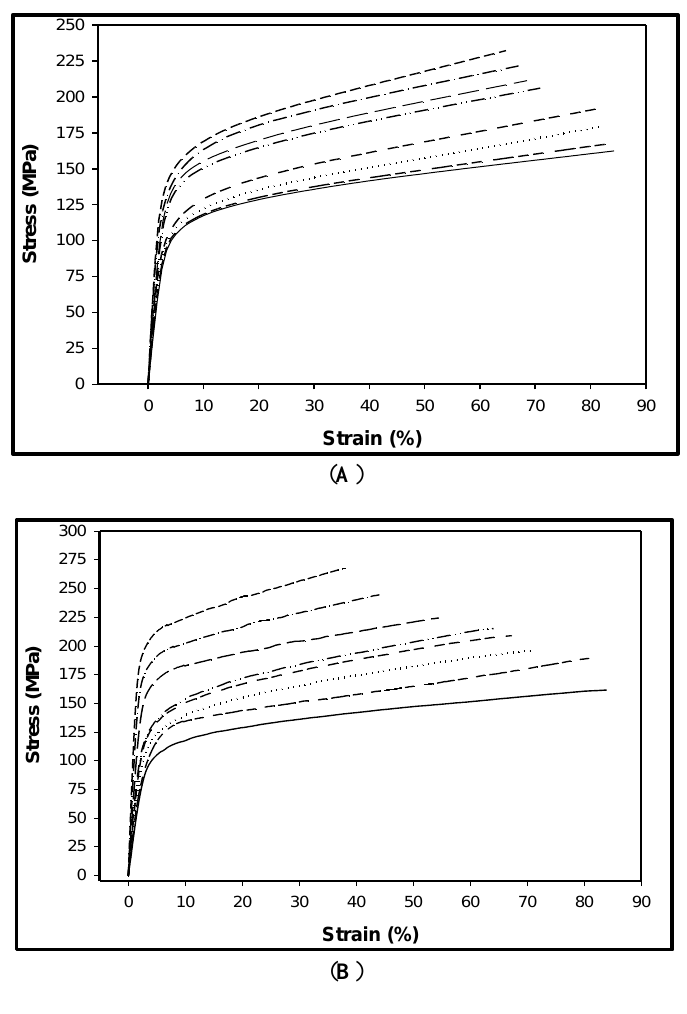
Figure 9. Stress vs strain curves of Ar-CNT-P ( A ) and AR-CNT-C ( B ) composite: CNT wt %: 0( ── ), 0.5 ( ), 1( ‥‥ ), 1.5 ( ), 2 ( ‥ ), 2.5 ( ̶ ̶ ), 5 ( ٠ ٠ ), 7.5 ( ).